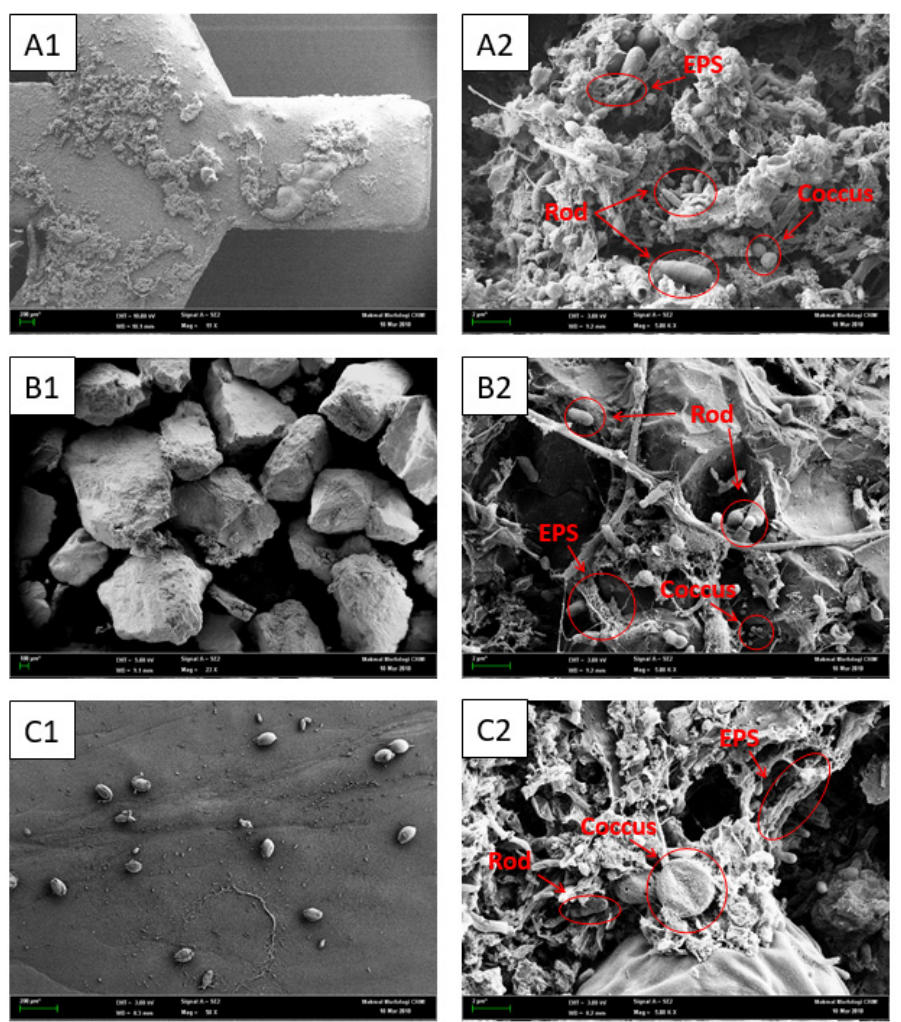
Figure 5. SEM micrographs for ( A ) Biofilm attached on HEX media: A1 at magnificent 19X, A2 at magnificent 5 k X, ( B ) biofilm attached on sand: B1 at magnificent 23X, B2 at magnificent 5 k X, and ( C ) suspended biomass in coffee mill effluent: C1 at magnificent 50X, C2 at magnificent 5 k X.